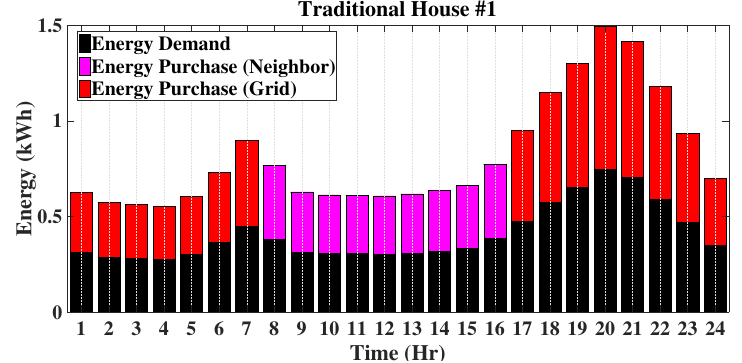
Figure 10. Energy profiles of Traditional House #1 on a typical summer